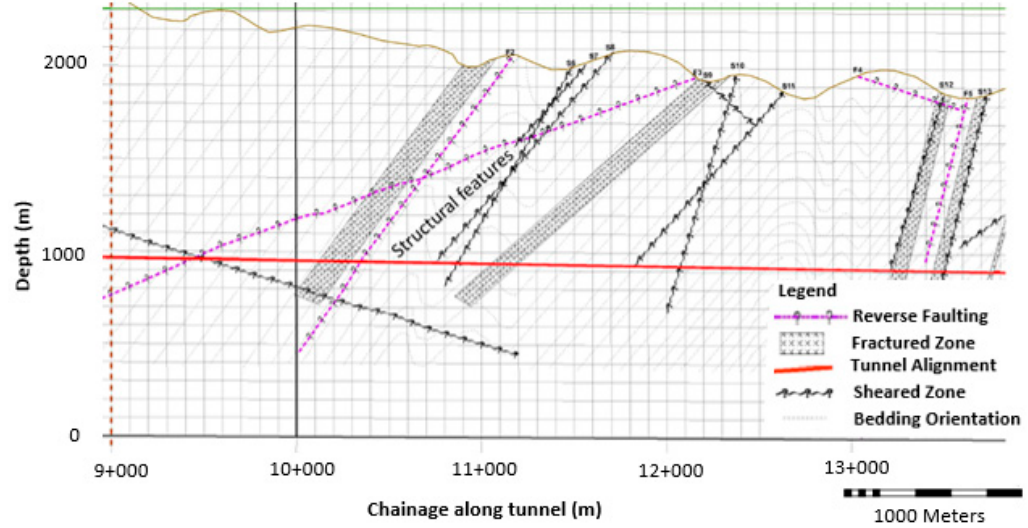
Figure 2. Longitudinal profile of headrace tunnel showing different structural features.